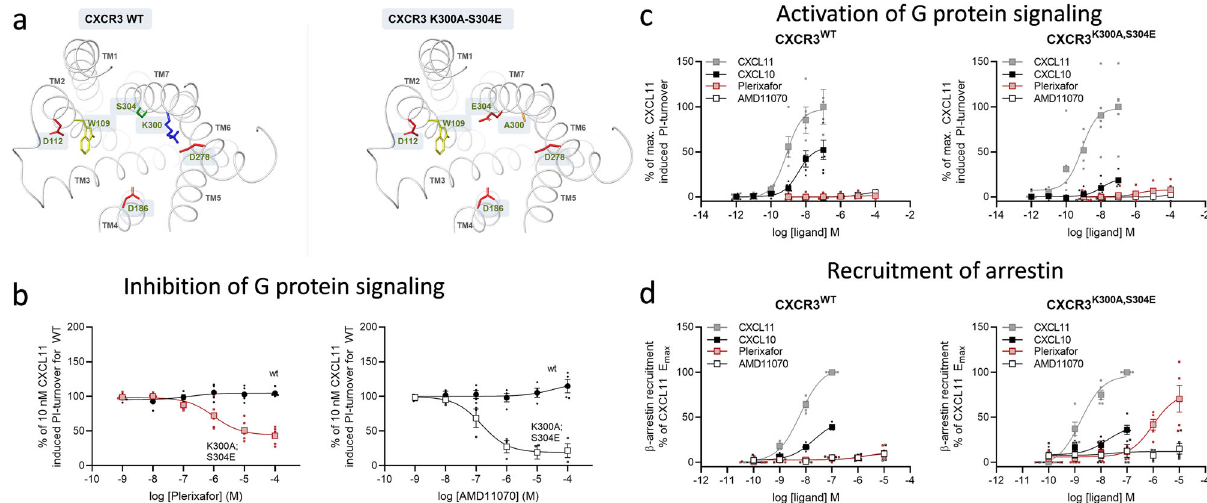
Fig. 4 Transfer of plerixafor to CXCR3 (also) reveals partial agonism. a Binding pocket of WT CXCR3 (left) and K300A-S304E mutant (right) shown from the extracellular side. Residues involved in plerixafor and AMD11070 binding in CXCR4 (Fig. 3) are shown as sticks. K300 and S304 in WT are mutated to A300 and E304, respectively. The wild-type CXCR3 model was retrieved from the GPCR-HGmod database 76 . Residues are colored according to side chains; red = acidic residue, blue = basic residue, yellow = aromatic residue, green = polar residue. b Antagonistic effect of plerixafor